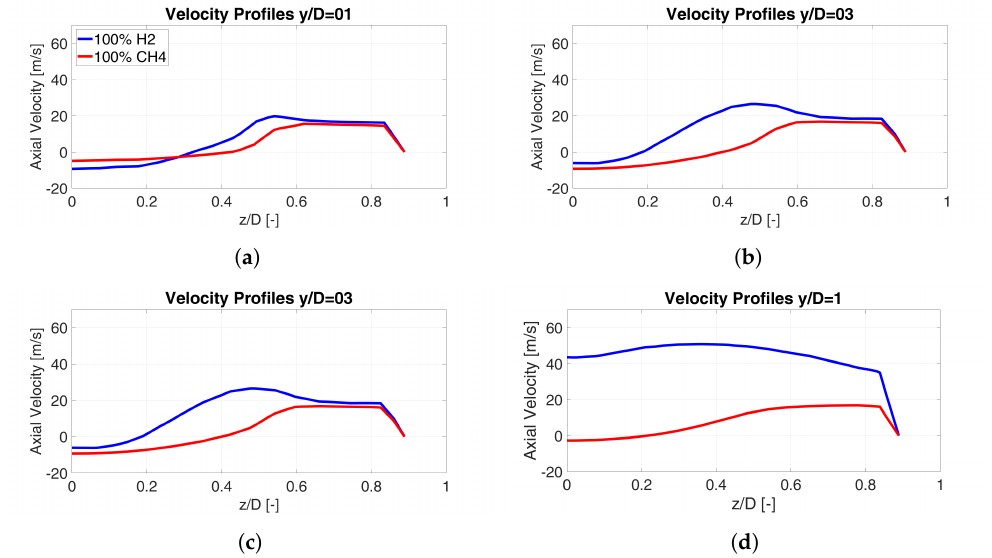
Figure 11. Comparison between the axial velocity profiles for the two different mixtures for the reaction flow, at different axial positions (( a ) y / D = 0.1, ( b ) y / D = 0.3, ( c ) y / D = 0.6, ( d ) y / D = 1).